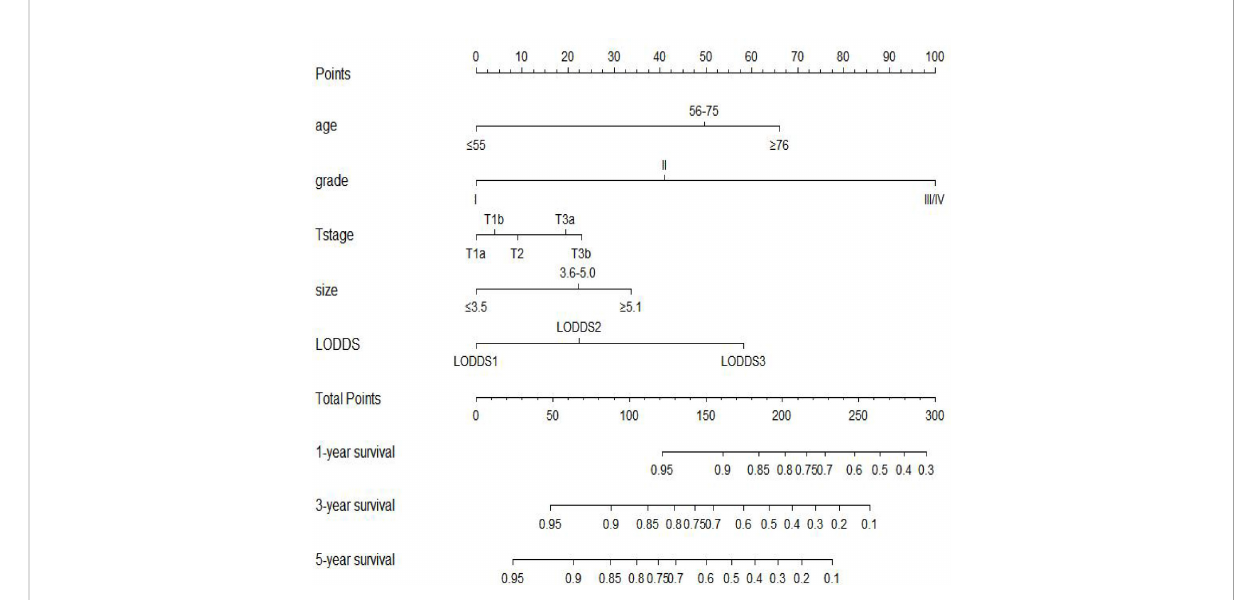
FIGURE 1 Prognostic nomogram to predict 1-, 3-, and 5-year overall survival in stage IIIC endometrial cancer patients with adjuvant radiotherapy